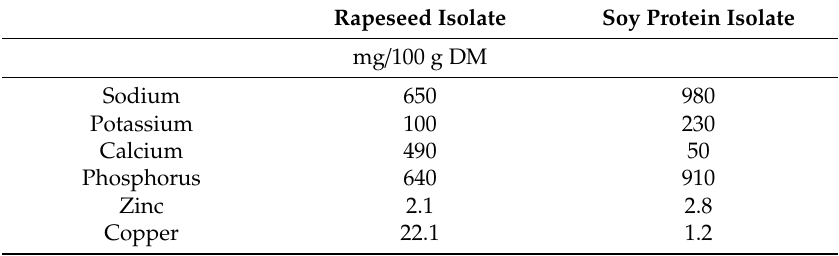
Table 3. Quantities of minerals in the protein isolates determined by